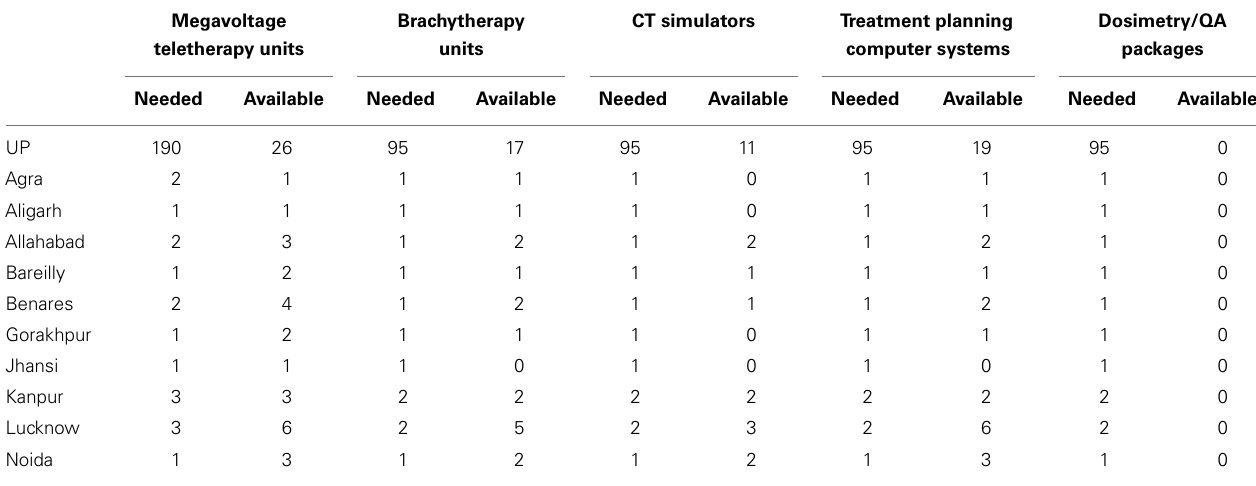
Table 6 | Radiation therapy equipment needed versus available for UP and its 10 cities with radiation therapy centers based upon GLOBOCAN 2008 data